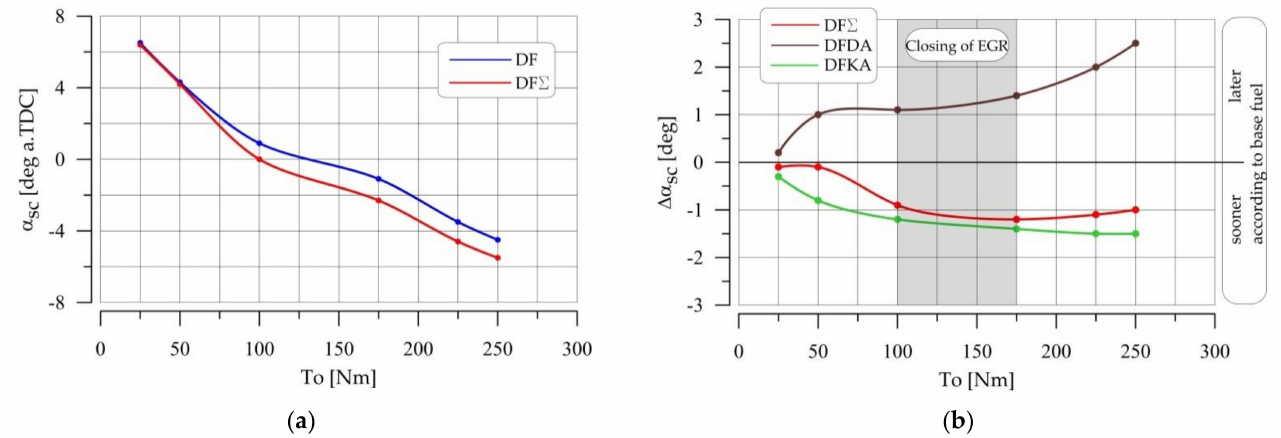
Figure 16. ( a ) Onset of fuel self-ignition vs. engine torque; ( b ) Difference in the onset of fuel self-ignition vs. engine torque in relation to the base fuel.